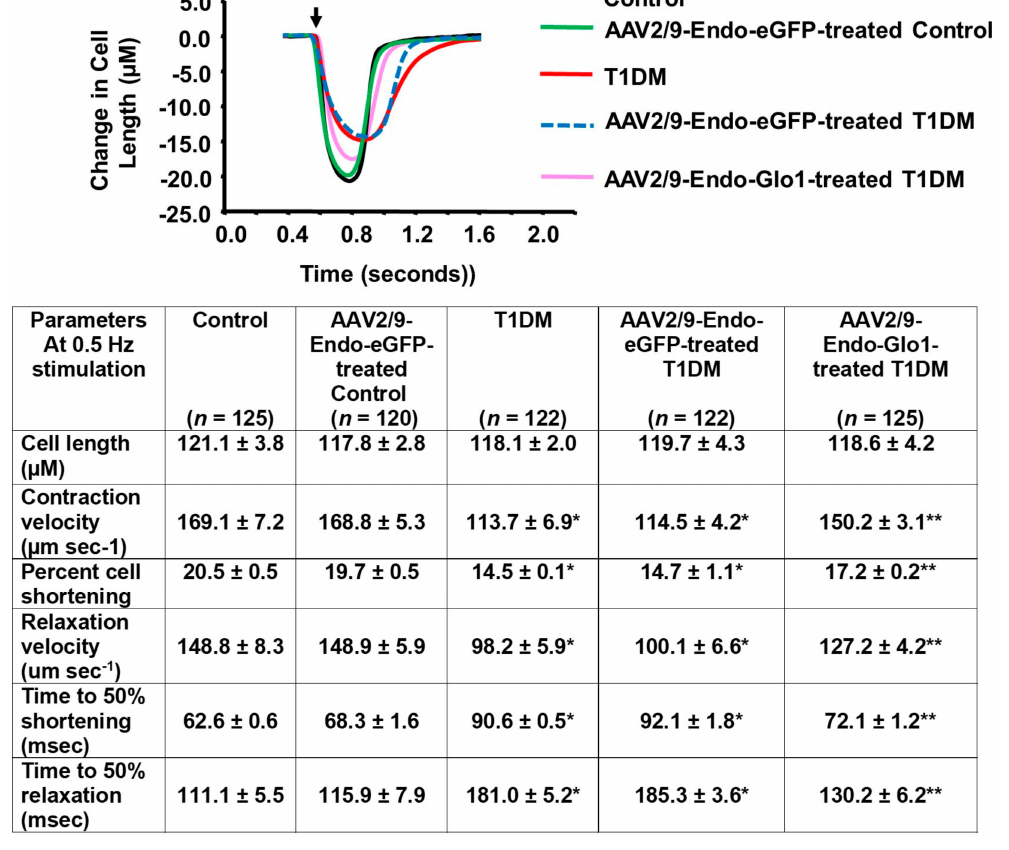
Figure 3. Data showing evoked contractile kinetics in left ventricular myocytes isolated from control, T1DM and T1DM-treated hearts. Images above are representative evoked contraction / relation profiles of ventricular myocyte isolated from the control, AAV2 / 9-Endo-eGFP-treated Con, T1DM, AAV2 / 9-Endo-eGFP-treated T1DM, and AAV2 / 9-Endo-Glo1-treated DM rats field-stimulated (10 V) for 10 ms at 0.5 Hz, using a pair of platinum wires placed on opposite sides of the chamber. The extent of myocyte shortening and rates of shortening and lengthening were determined using IonWizard Version 5.0 and means ± S.E.M for n > 120 cells from n = 5 animals are shown in the table